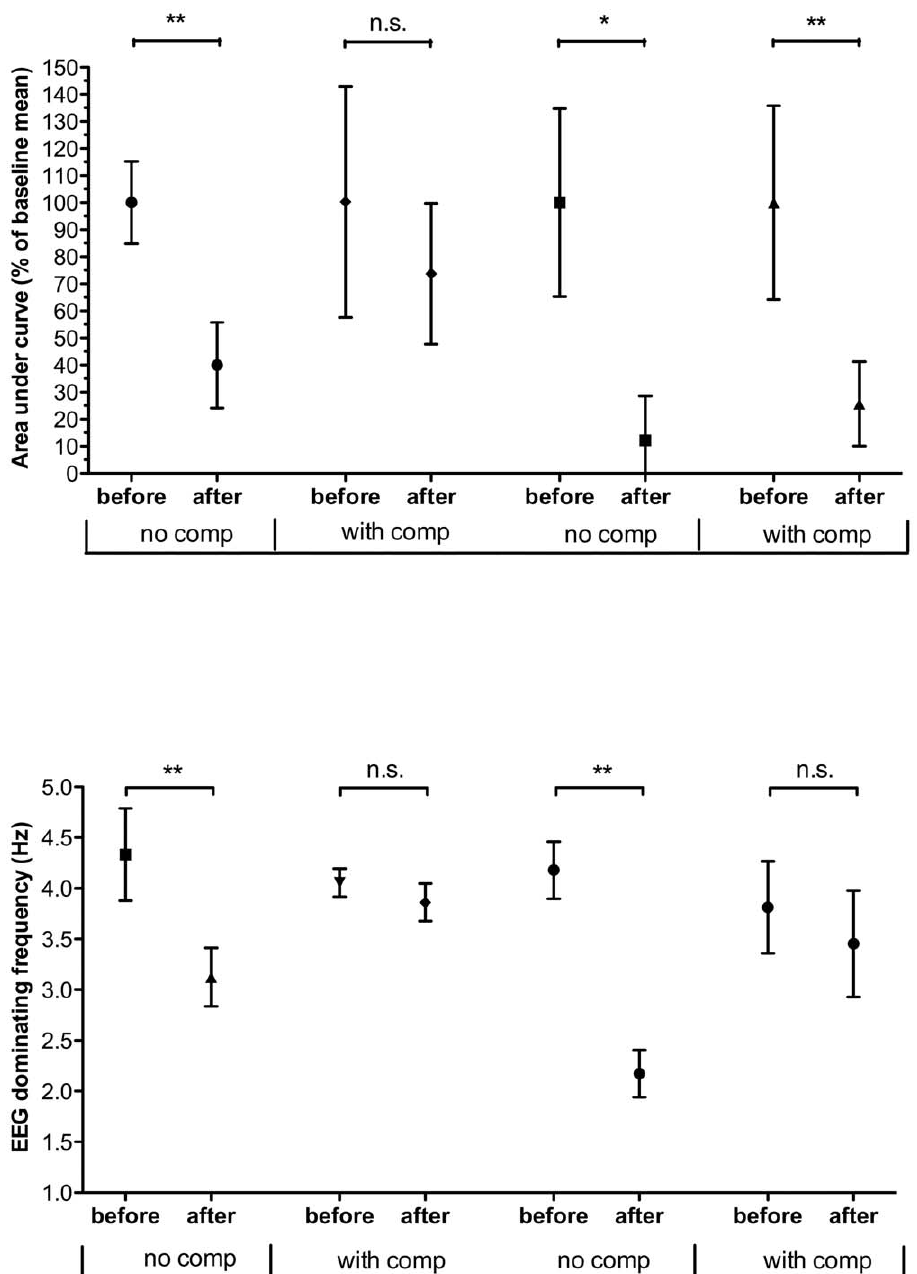
keep a stable dominant EEG frequency after drug. ‘‘before’’ represents baseline measurements before drug and ‘‘after’’ represents LCEPs elicited after drug administration. Left part of the figure shows data from 1 mg/kg and right part shows data from 3 mg/kg Morphine. The results from student’s t- test are also shown. See methods section for details.